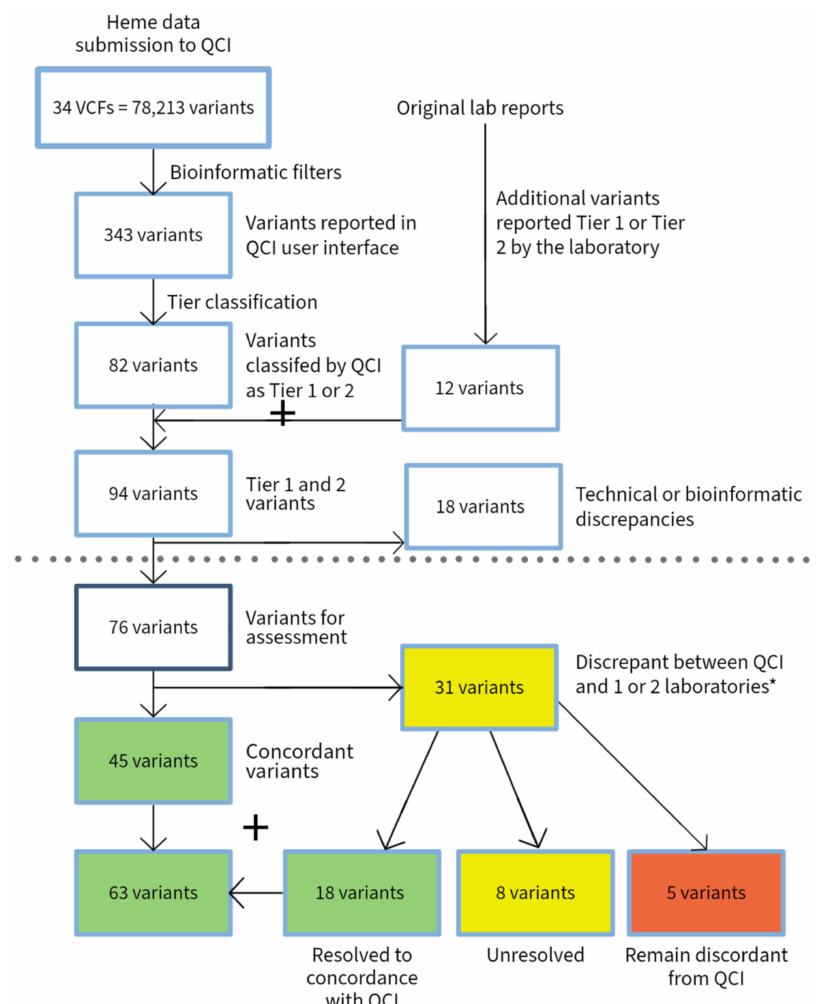
Figure 2. Flow diagram of data from hematologic malignancies. * Discrepancy between laboratories 1 and 2 may indicate agreement with QCI from at least one